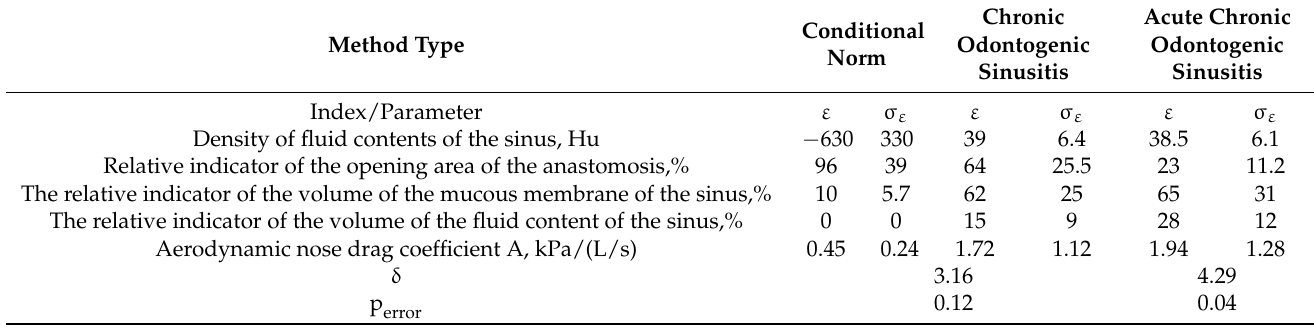
Table 2. Comparison (control) of the norm with chronic odontogenic sinusitis and exacerbated chronic odontogenic sinusitis.